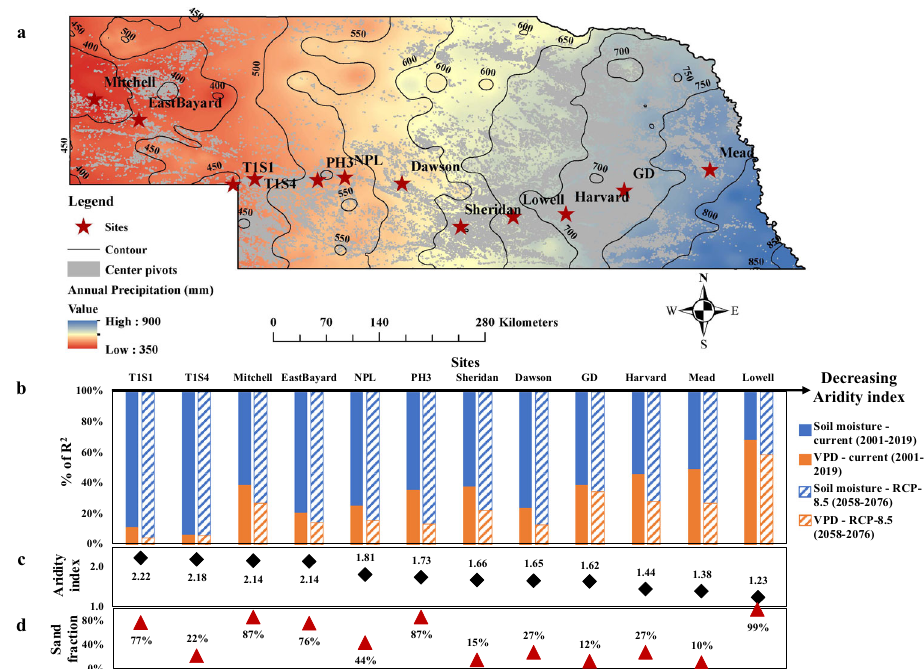
Fig. 3 Spatial variability of the co-regulation pattern of soil moisture and VPD on stomatal conductance of maize in Nebraska, United States. a Location of 12 sites with a large rainfall gradient (from 800 mm in the east to 400 mm in the west) in Nebraska. b The relative importance metrics of soil moisture and VPD as drivers of variability in stomatal conductance (from ecosys ) across 12 sites in Nebraska under current climate (2001-2019) and RCP- 8.5 scenario (2058- 2076). c , d Variation of aridity index and sand fraction across 12 sites in Nebraska. Aridity index was calculated as the ratio of potential evapotranspiration 31 (PET, mm) and precipitation (P, mm) during growing season from 2001 to 2019, i.e.